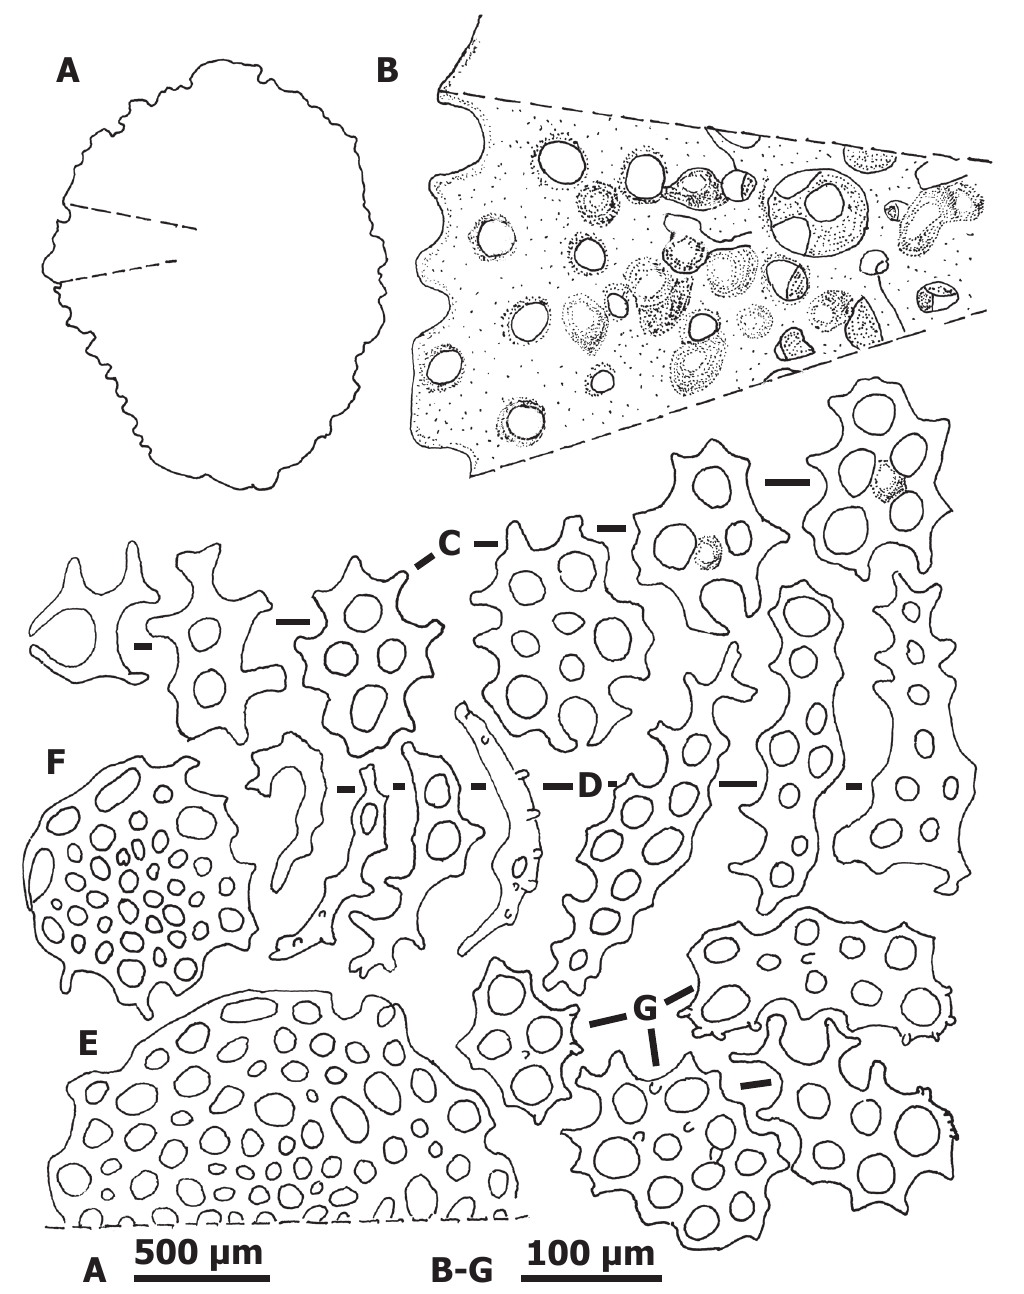
Fig. 2. Psolus tessellatus Koehler, 1896. A . Dorsal scale. B . Detail of dorsal scale. C . Plates of ventral sole. D . Rods of large tube feet. E . End plate of large tube feet. F . End plate of small tube feet. G . Perforated plates at the base of the large tube